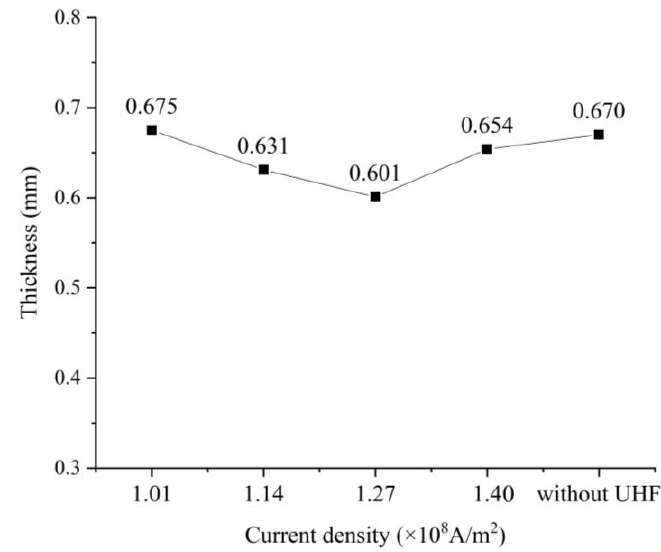
Figure 9. Thickness of the deposited layer.